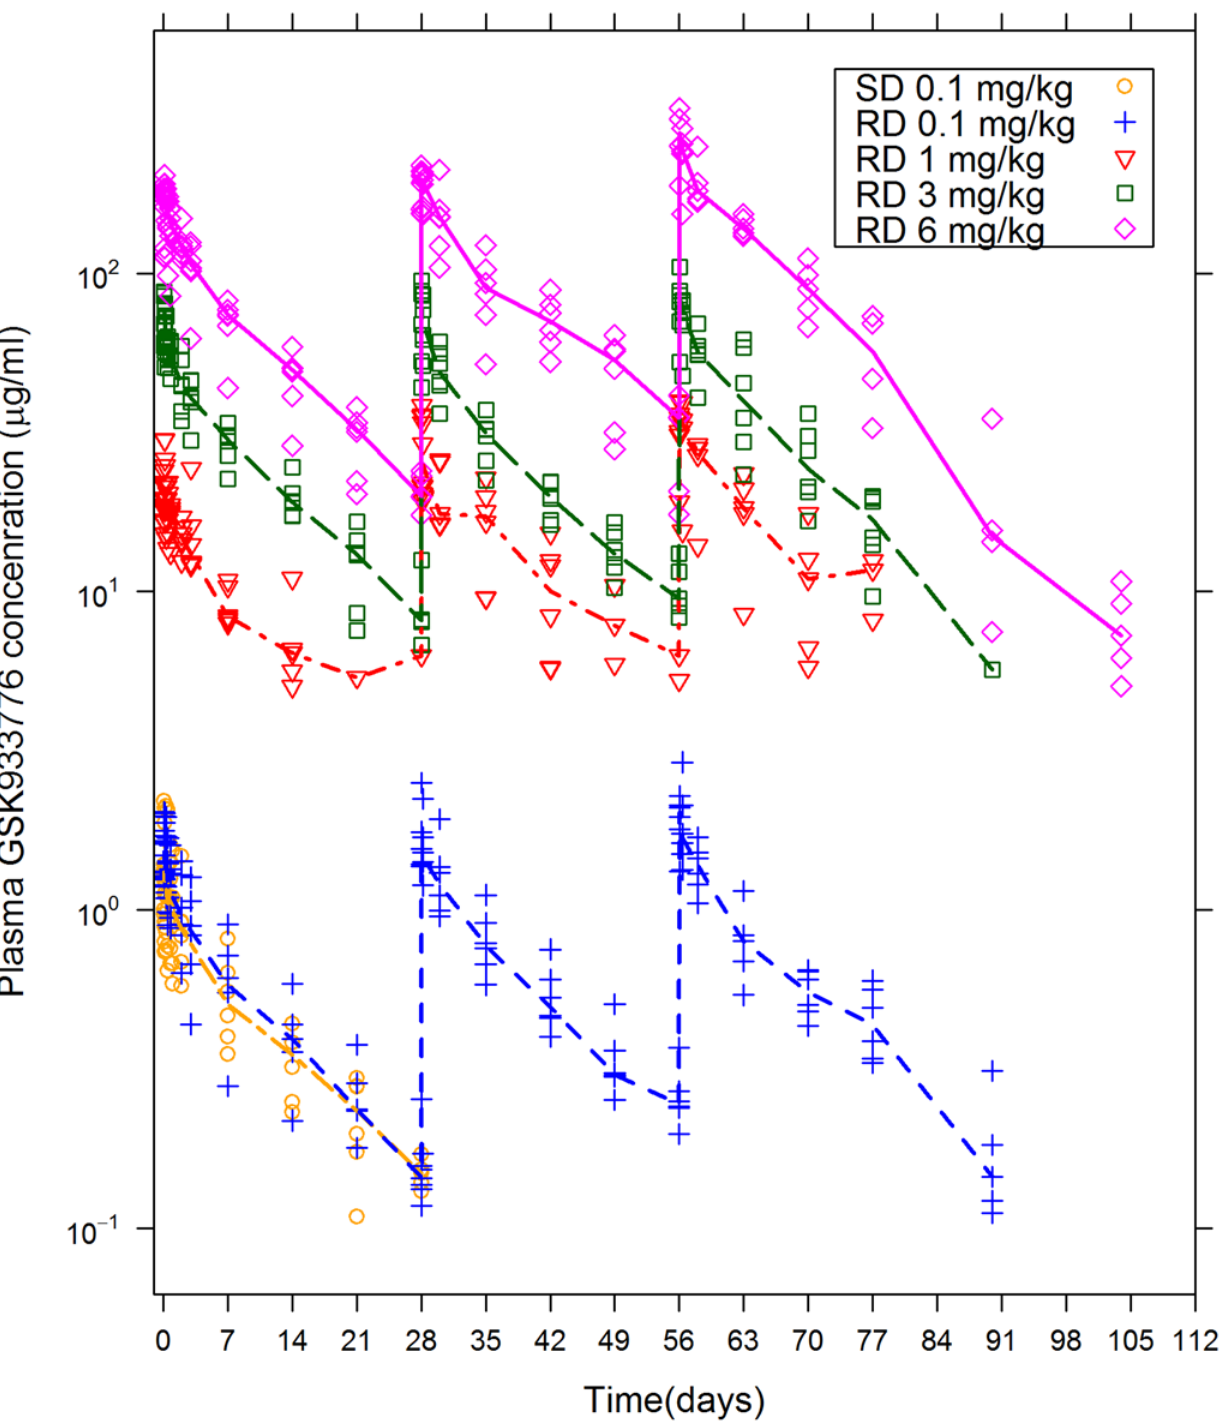
Fig 2. GSK933776 plasma pharmacokinetics. Time-course of plasma concentrations of GSK933776 by dose: medians (lines) and individual data (dots). LLQ is 100 ng/mL for the 0.1 mg/kg dose and 5 μ g/mL for the 1, 3, and 6 mg/kg doses. SD = single dose; RD = repeat dose. Maximum plasma concentrations increased with